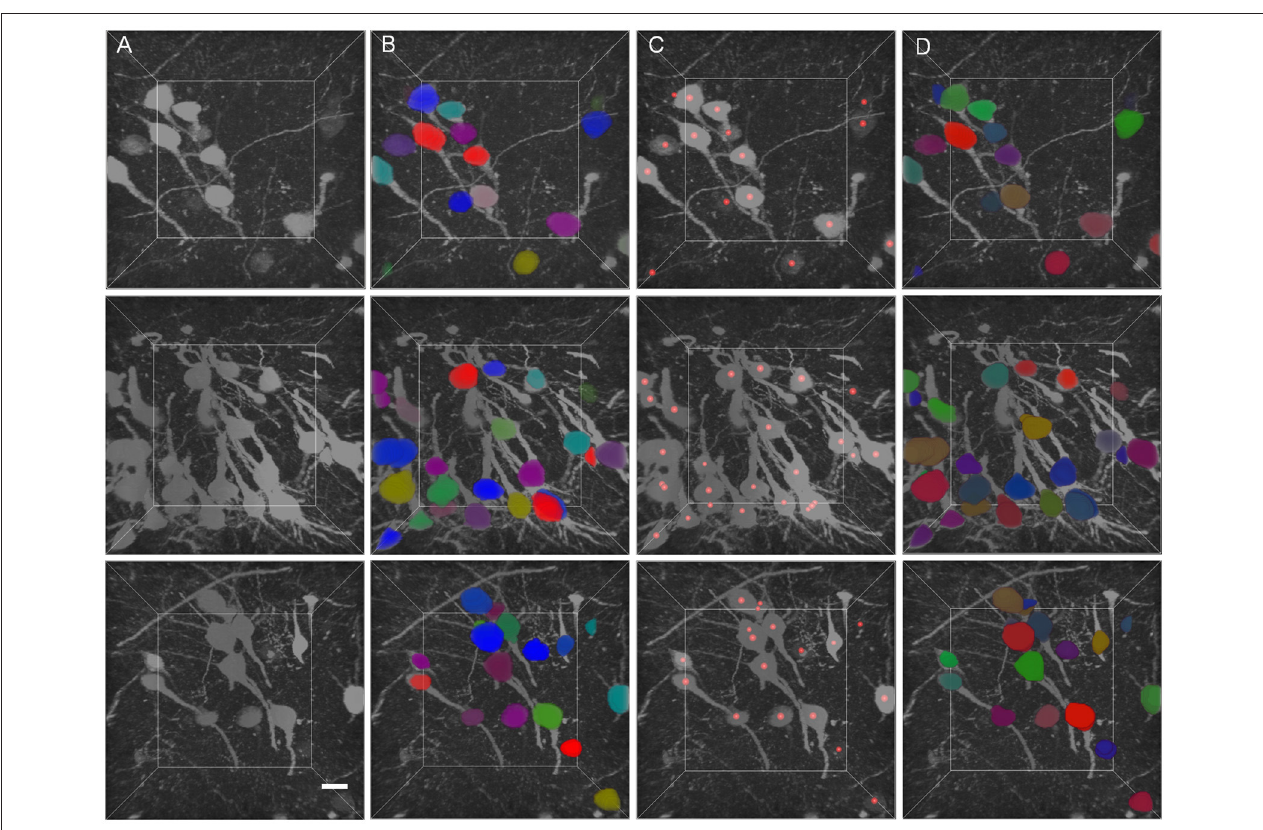
FIGURE 8 | Validation of proposed method in GFP dataset. (A) Raw volumetric data from GFP dataset. (B) Manual labels. (C) localization results. (D) Segmentation results. Each neuronal soma in (B) and (D) is labeled by unique random color. The neuronal soma localization results are represented by red balls. The intensity of raw data is adapted for visualization. The shape of each volumetric data is 200 × 200 × 200 voxels, and the voxel size is 0.5 × 0.5 × 0.5 µ m. The horizontal bar indicates 10 µ